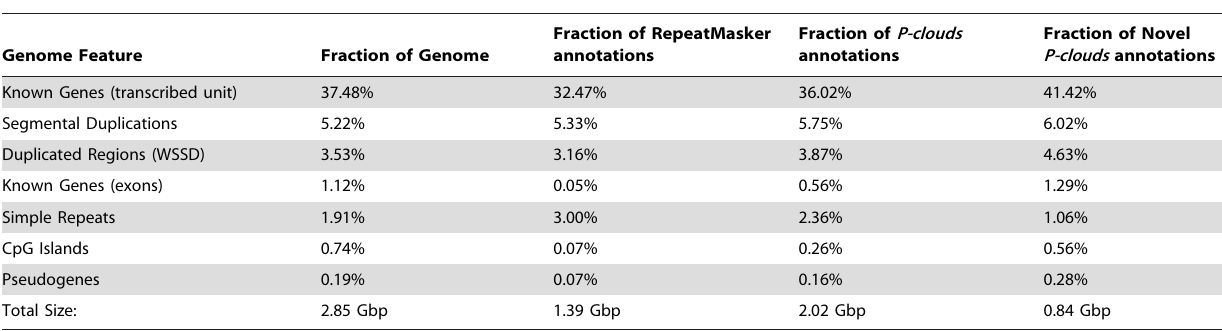
Table 1. Overlap between genome features and repetitive